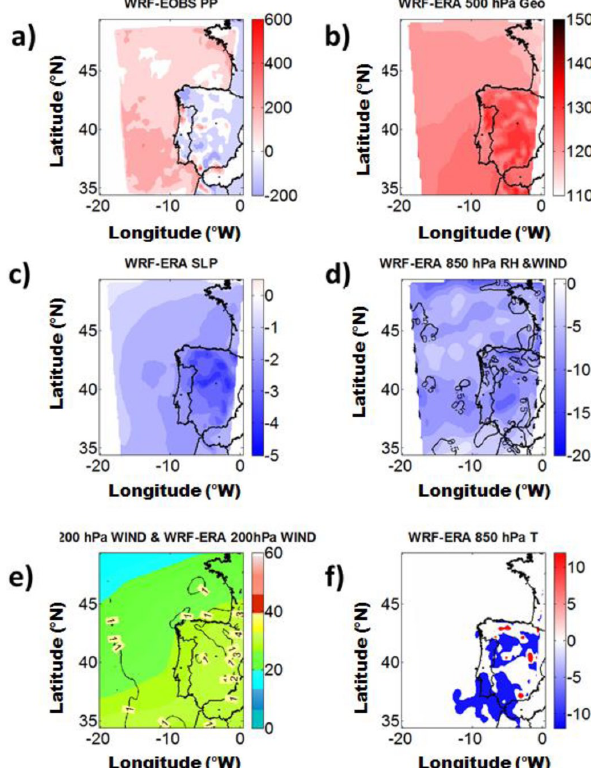
Fig. 4. Averaged differences between WRF and ERA/observations, during December 2009, for (a) precipitation (mm), (b) 500hPa geopotential height (dam), (c) seal level pressure (hPa), (d) 850hPa relative humidity (%, colour shaded) and wind differences (ms − 1 ,contour), (e) 200hPa observed wind speed (ms − 1 ) averaged for December 2009 (shaded) and the difference between WRF and observations (contour) and (f) 850hPa temperature (K). The reanal- yses are from the ERA dataset except for precipitation that are from EOBS